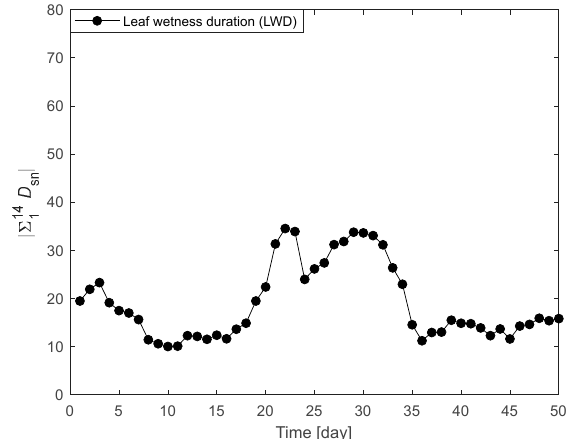
Figure 9. Variation of the classification potential ( D sn values) with daily calculated leaf wetness duration. Day 1 on the x -axis is the first day of the growing season.